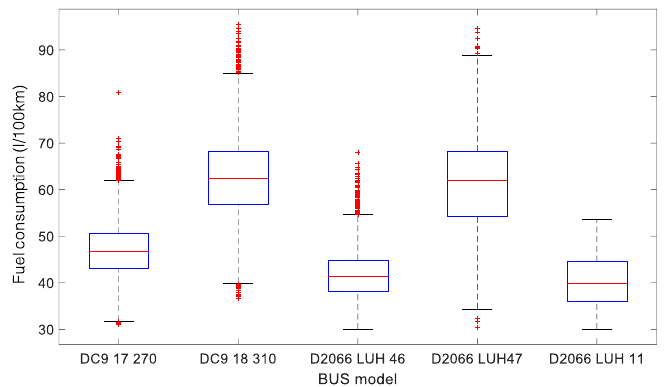
Figure 4. Boxplot of fuel consumption vs. BUS model.